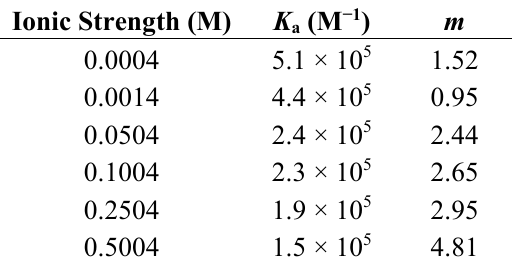
Table 2. Calculated values of the quenching constants and their corresponding number of bound molecules for the 1:2 Zr(IV)-substituted Wells-Dawson POM:HSA complex at different ionic strength